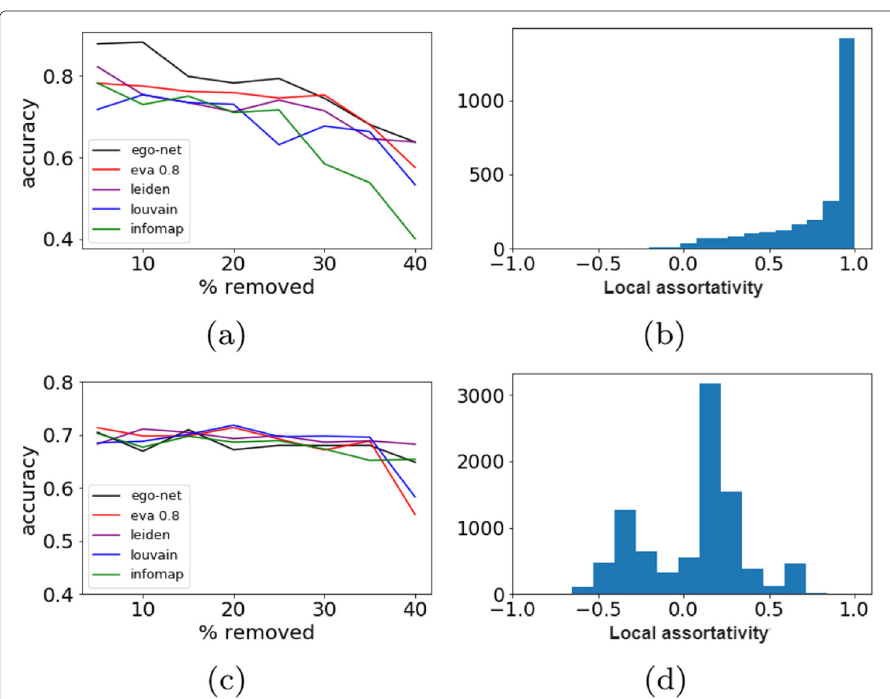
Fig. 5 Prediction accuracy comparisons and network local assortativity distributions: a - b Cora , c - d